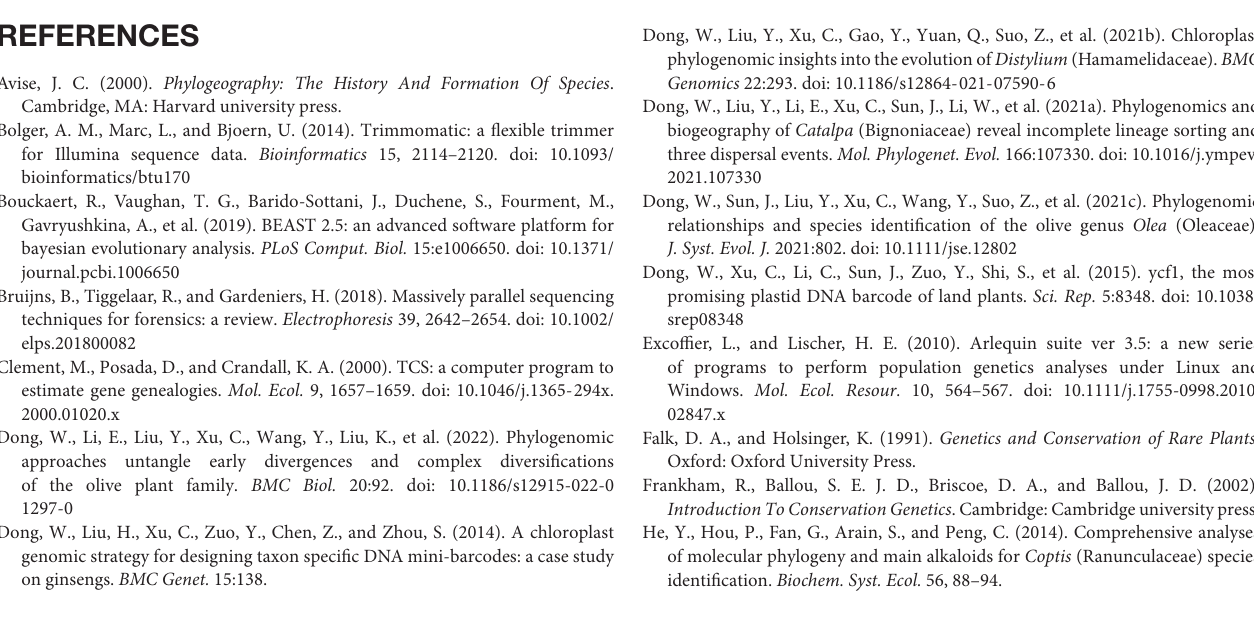
Supplementary Figure 1 | The boxplot of Pi values and indels in Ccb and Ccc. Supplementary Figure 2 | The maximum likelihood phylogeny of Coptis . Supplementary Figure 3 | The delta K value of STRUCTURE